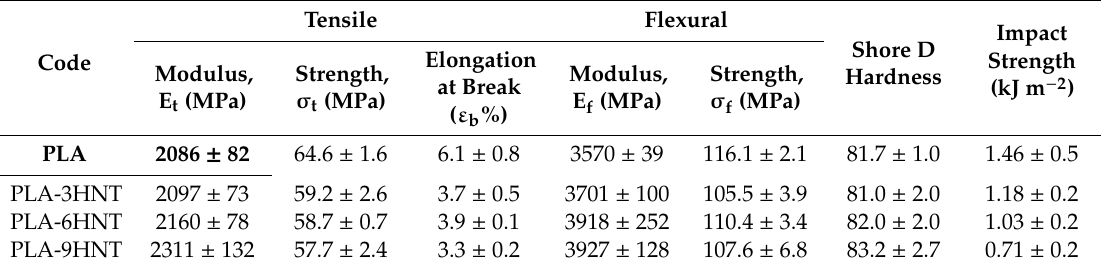
Mechanical properties of PLA / HNTs composites obtained from tensile tests